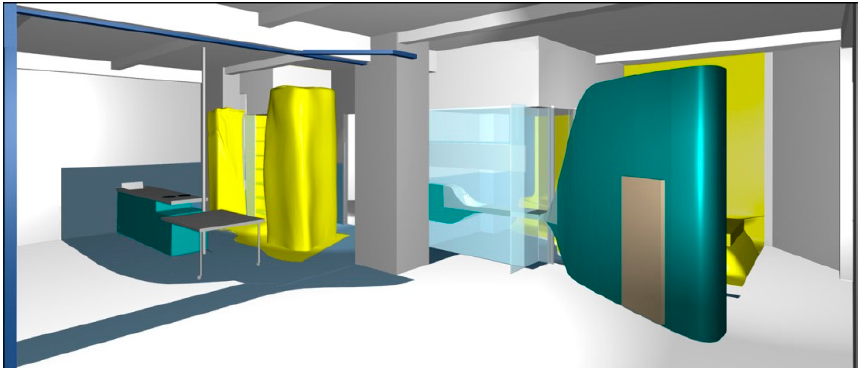
Figure 10. KOL/MAC, O-K apartment. Rendering of a living area showing the kitchen and kitchen/bath element, master bedroom, and wardrobe, 1997. Part of AP185.S2.025, last modified 26 February 1997. Gift of and © KOL/MAC.